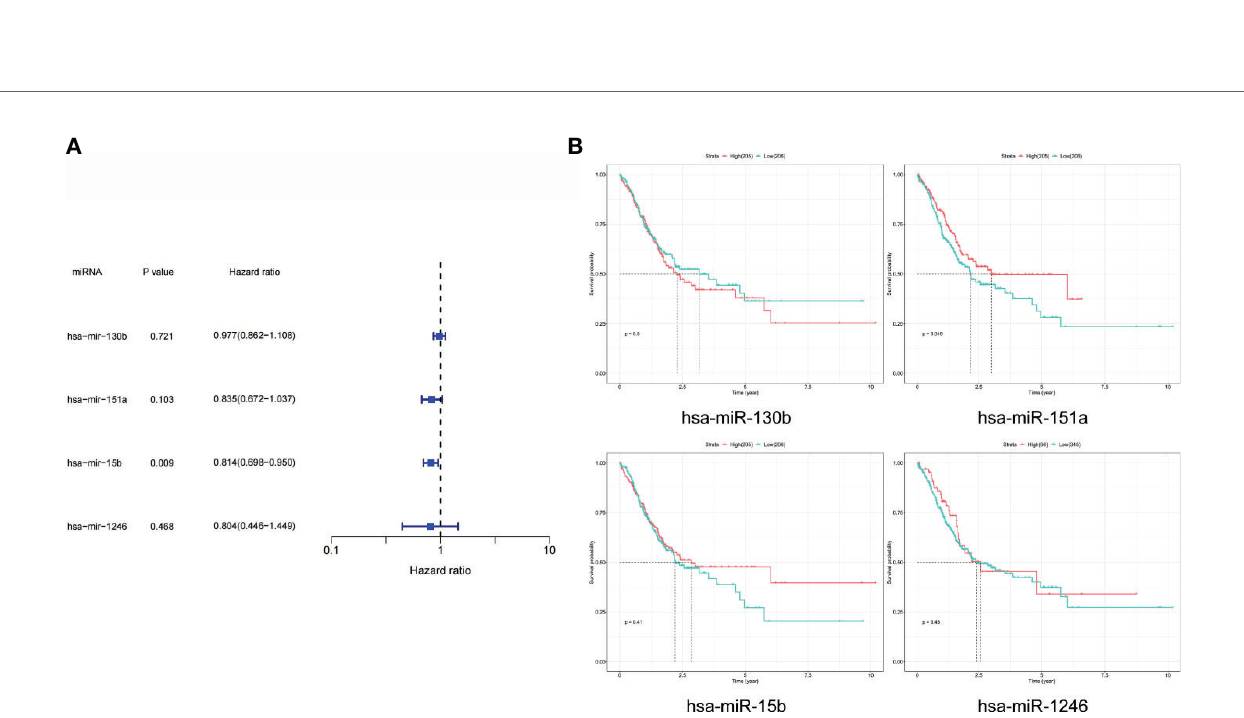
FIGURE 3 | Expression analysis of DEmiRNAs in TCGA and EVmiRNA. (A) The expression level of DEmiRNAs in TCGA dataset. (B) EVmiRNA